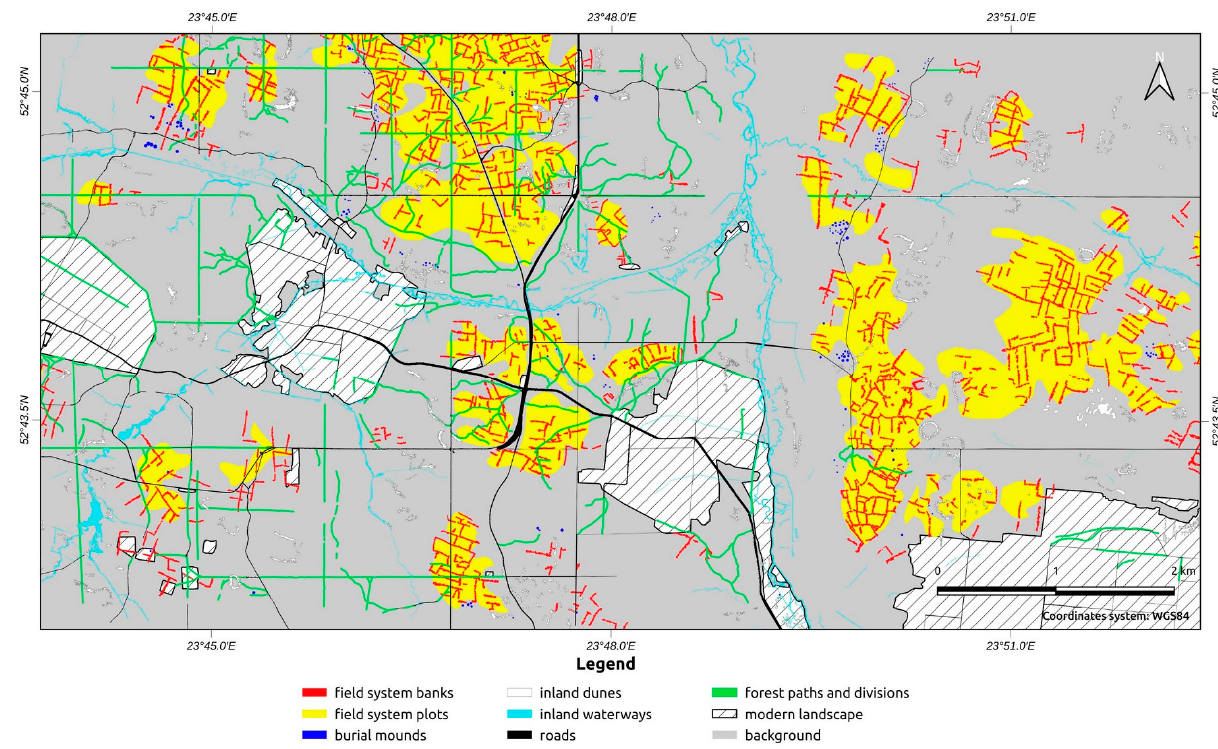
Figure 3. Manually drawn ground truth mask of the training area.